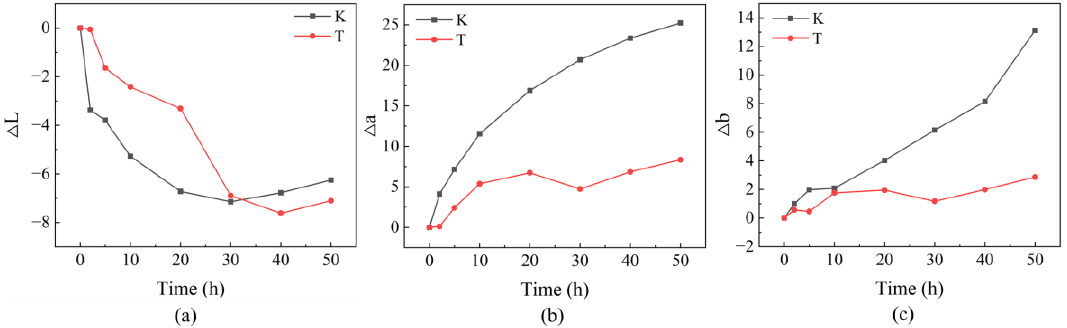
Figure 6. ( a ) ∆L, ( b ) ∆a, and ( c ) ∆b changes of dyed wood (K) and treated wood (T) with respect to UV light irradiation. UV light